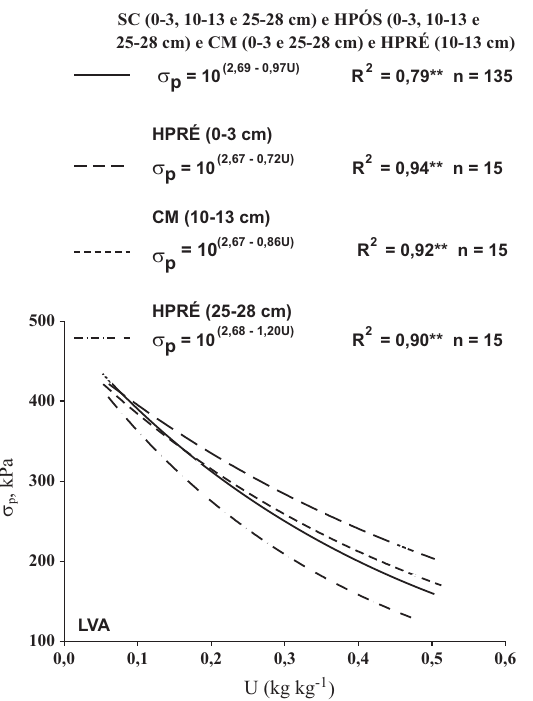
Figura 5. Modelos de capacidade de suporte de carga (CSC) para o centro da entrelinha, para as camadas de 0–3, 10–13 e 25–28 cm, submetidos a diferentes sistemas de manejo das